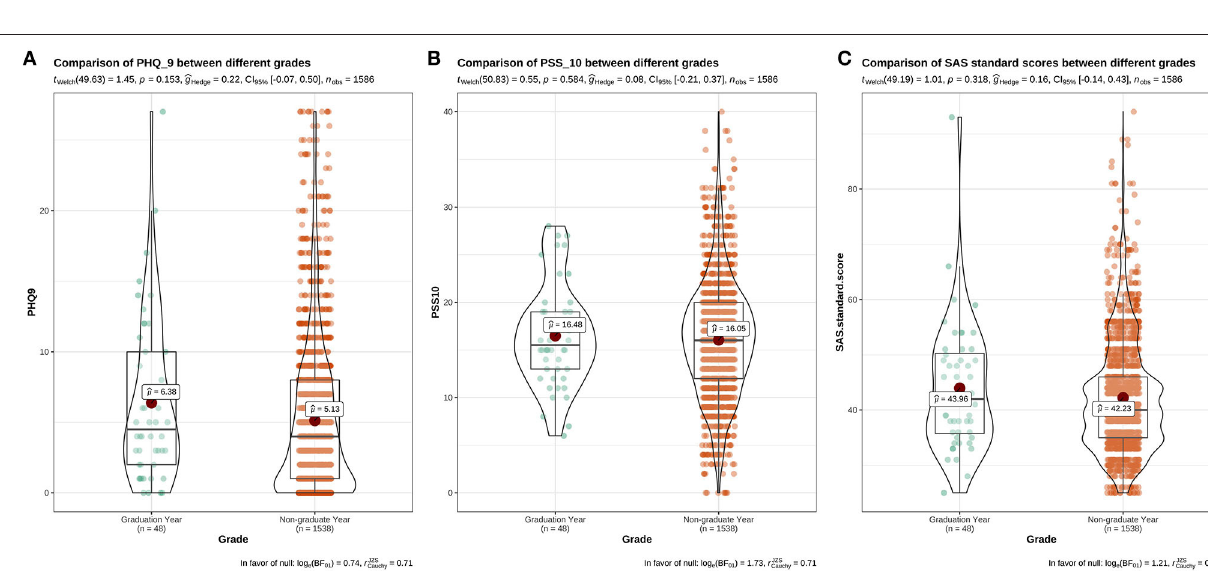
worried about the uncertainty of the future development of the